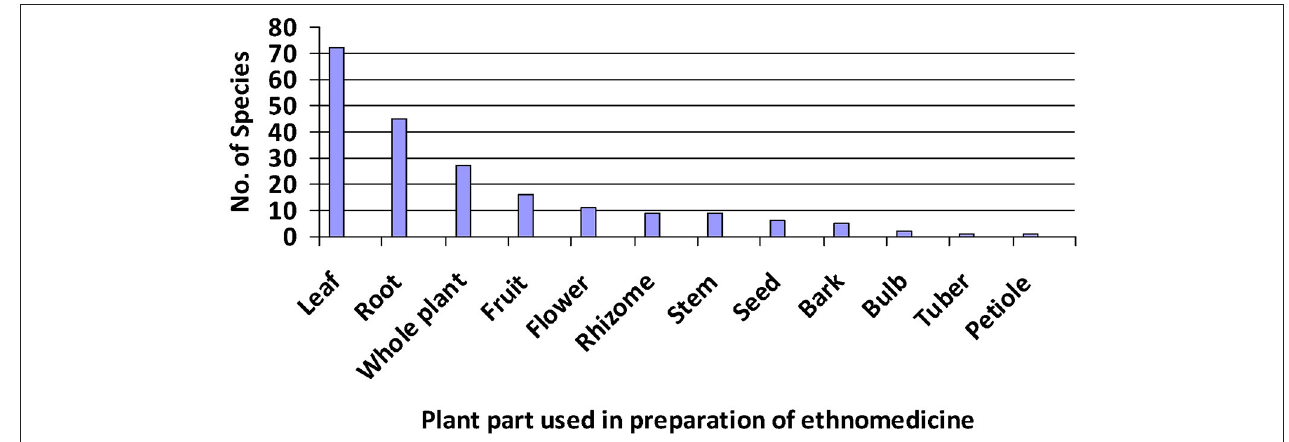
FIGURE 2 | List of plant parts along with their frequency of use among species recorded for the preparation of